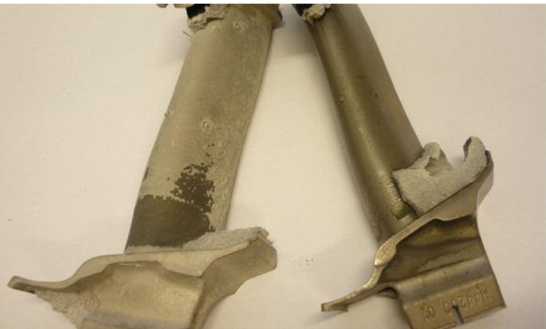
Figure 19. A workpiece of nickel-based superalloy before (left) and after (right) electropolishing in ethaline 200 (reprinted with permission from ref. [60]; Copyright 2013 the author(s), published by Informa UK Limited, trading as Taylor & Francis